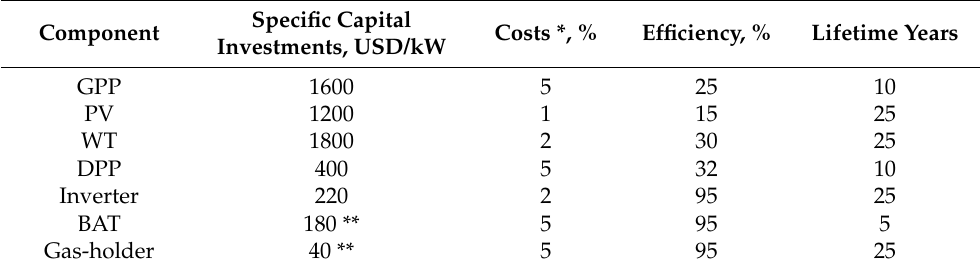
Table 5. Technical and economic performance indicators of system components.